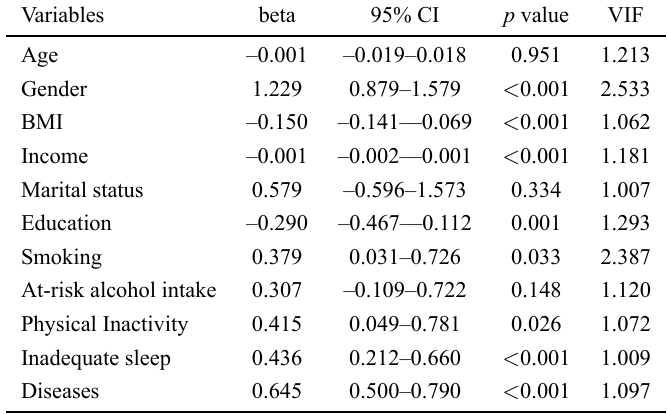
Table 3. Linear regression analysis for the determinants of